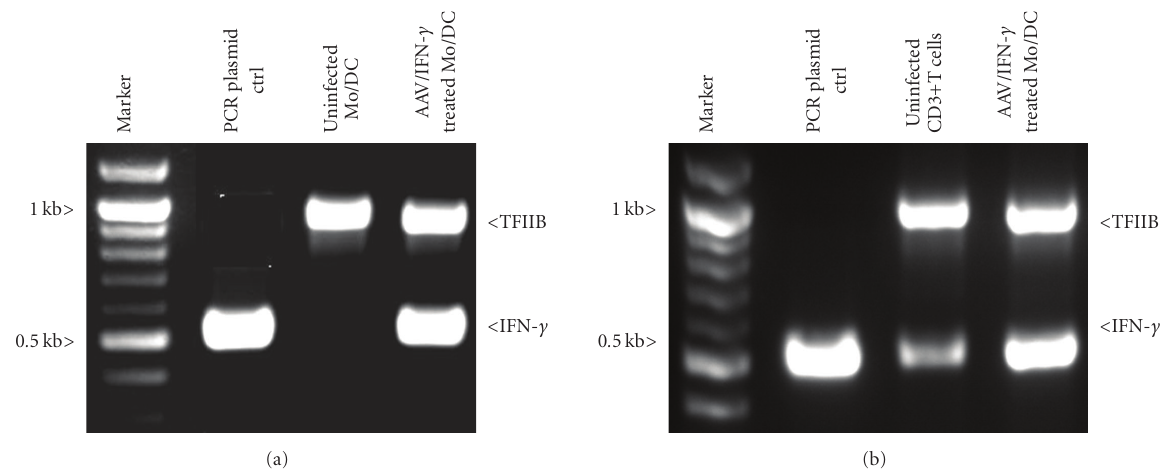
Figure 3: Analysis of IFN- γ expression in transduced DC and T cells by RT-PCR. Cells were infected, mRNA isolated and analyzed by RT- PCR as described in Section 2. (a) shows the results from DC. (b) shows the results from T cells. Note that both AAV/IFN- γ transduced DC and T cells demonstrate IFN- γ expression. Also note that untransduced T cells expressed some IFN- γ , but that AAV/IFN- γ transduced T cells demonstrate higher IFN- γ expression. This is confirmed in Figure 4.